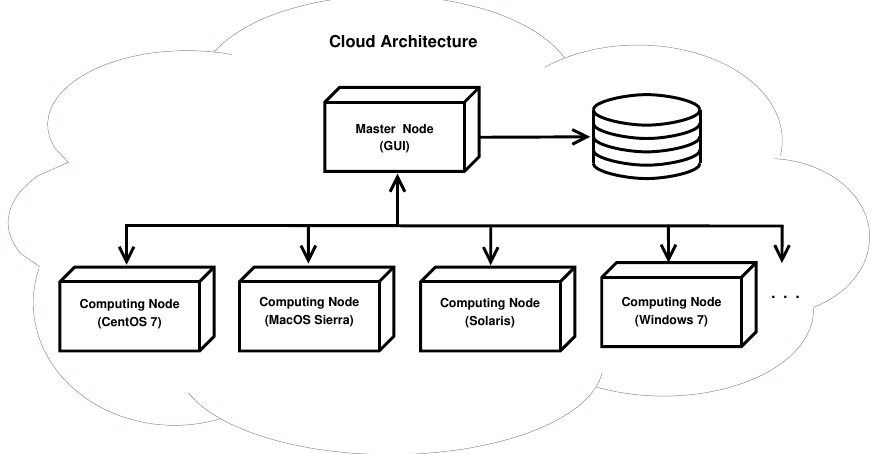
Figure 4. The cloud-based architecture of Yet Another Prolog Test Bench Environment (YAPTBE).